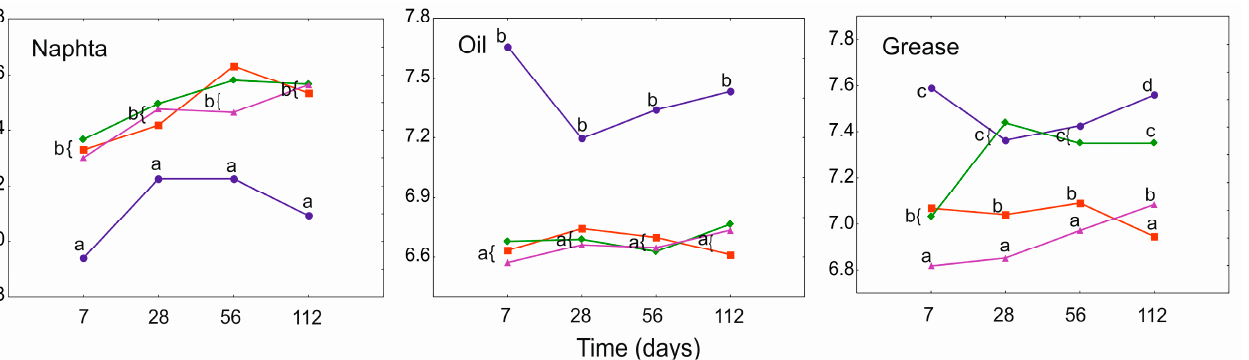
Figure 2. GLMM for mean hydrocarbon mass loss of heavy naphtha, lubrication oil, and grease for PGA treatment (blue and circle—PGA 0 , red and square—PGA 1 , green and diamond—PGA 1B , violet and triangle—PGA 10 ) and time (days). The different letters indicate the pairwise differences accord- ing to Duncan pairwise test. Mean values, standard error, and confidence intervals are included in Supplementary Material Table S1.